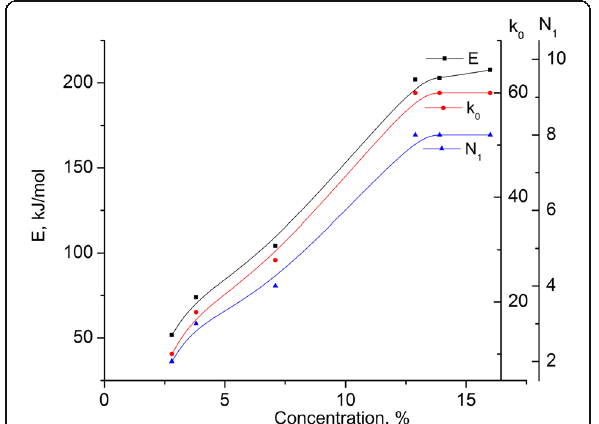
h i Fig. 5 Dependencies of activation energy ( E ), pre-exponential factor on the reverse temperature for Fig. 4 Dependence of ln − dQ = dt ( k 0 ), and number of hydrogen bonds N 1 for the samples of MCC. Q n h i Dependencies of activation energy ( E ), pre-exponential factor ( k 0 ), different orders of reaction. Dependence of ln − dQ = dt on the Q n and number of hydrogen bonds N 1 for the samples of MCC with reverse temperature for different orders of reaction different water content